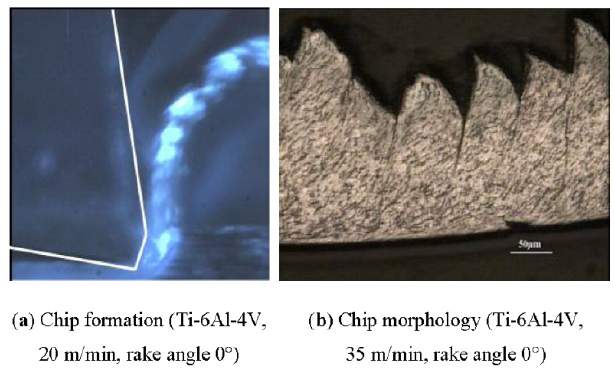
Figure 10. Ti-6Al-4V alloy chip formation ( a ) (by high speed camera), and morphology ( b ).